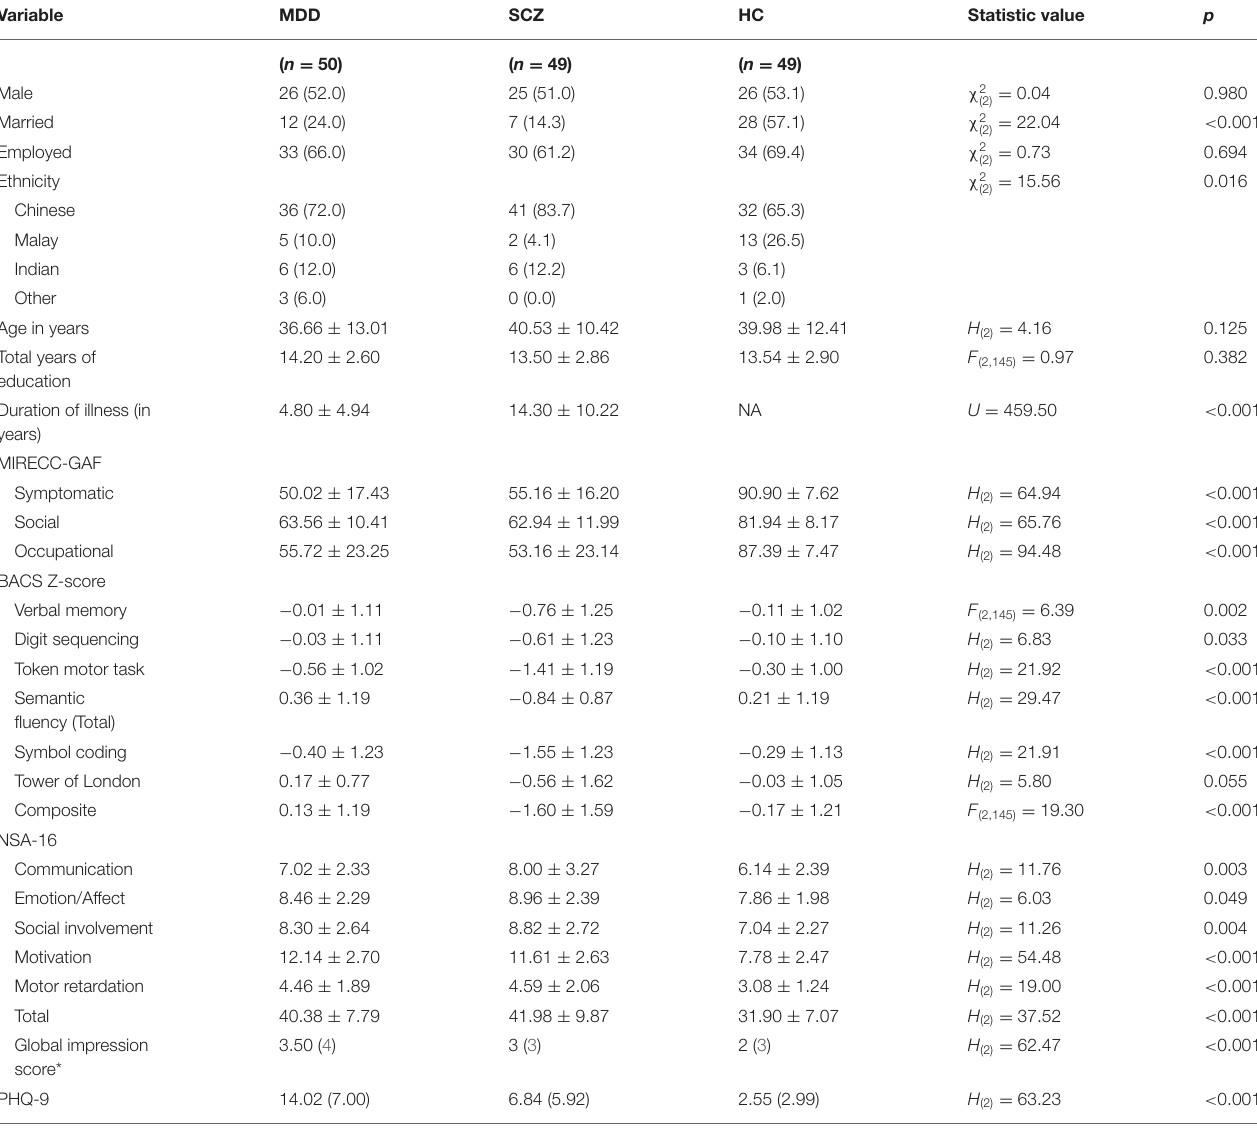
TABLE 1 | Demographic and clinical